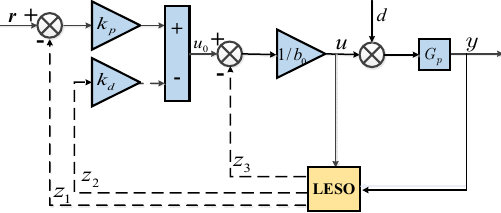
Figure 4. Second-order linear active disturbance rejection control (LADRC) structure diagram.